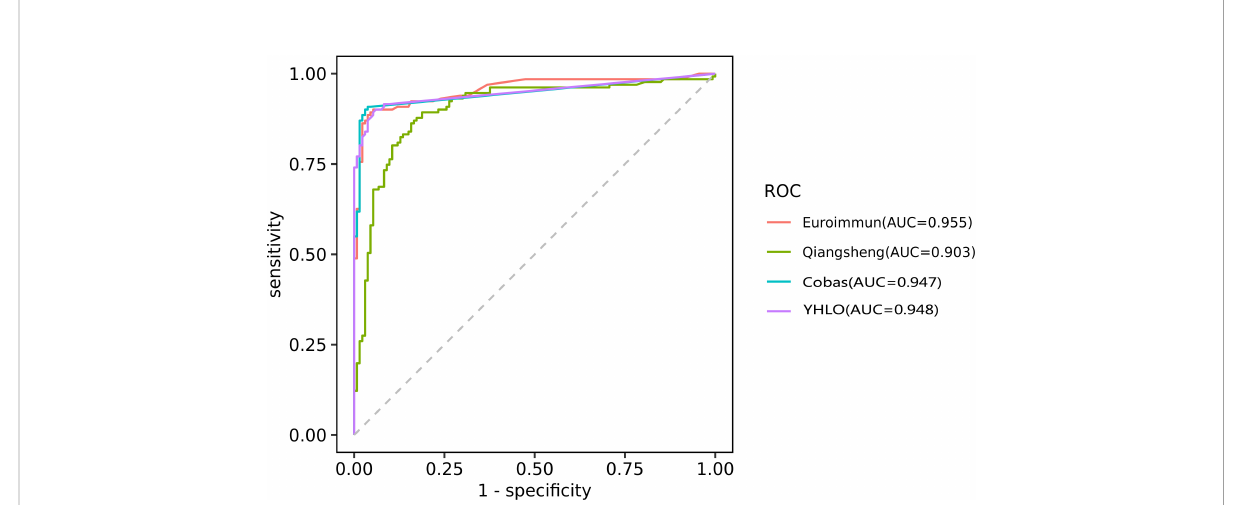
Figure 3 ROC curve analysis evaluating the diagnostic performance of the EUROIMMUN-anti-CCP ELISA, Qiangsheng, Elecsys anti-CCP ECLIA (Cobas) and the anti-CCP CLIA (YHLO) for RA.AUC as a measure of diagnostic performance: [citation: Mandrekar JN. Receiver operating characteristic curve in diagnostic test assessment. J Thorac Oncol. 2010;5 (9):1315-1316. doi:10.1097/JTO.0b013e3181ec173d] 0.5, no discrimination 0.7-0.8, acceptable 0.8-0.9, excellent >0.9,